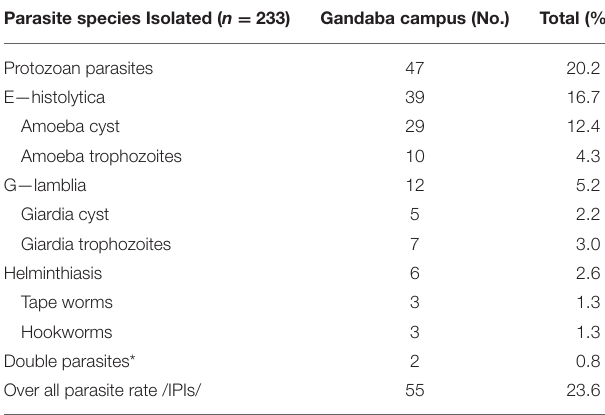
TABLE 3 | Knowledge of food handlers worked in the students’ caterings of WSU, Wolaita Sodo, South Ethiopia from January 10 to February 10, 2016. Knowledge